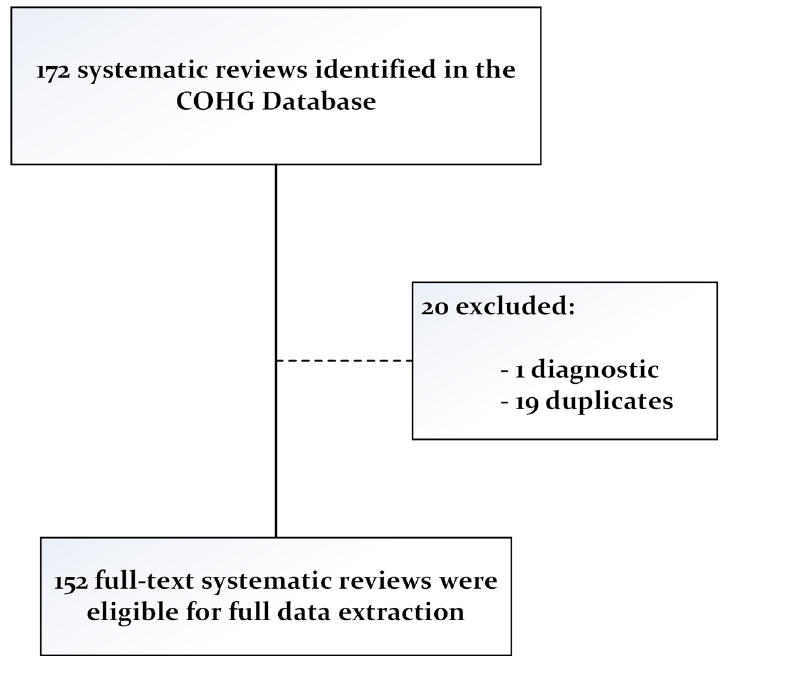
Fig 1. SR selection flow